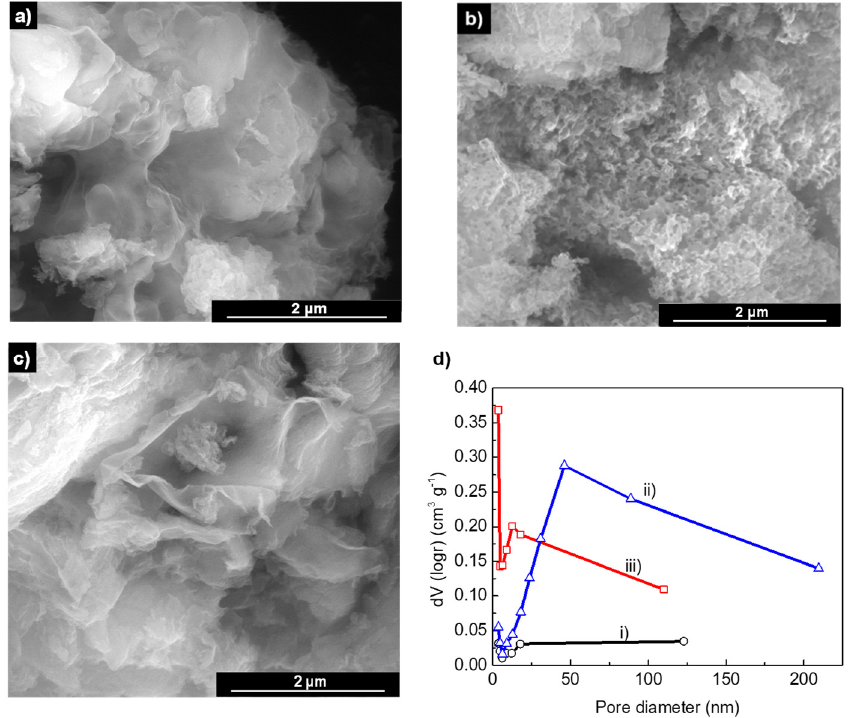
Figure 1. SEM micrographs of ( a ) GCN, ( b ) GCN-T-N, and ( c ) GCN-T. ( d ) Barrett–Joyner–Halenda pore volume distribution derived from the N 2 adsorption isotherms of (i) GCN, (ii) GCN-T-N, and (iii) GCN-T at − 196 °C. Table 1. The atomic ratio between carbon and nitrogen, specific surface area ( S BET ), XRD peak (002) width at half height (FWHM), and crystallite size ( d ) of the synthesized catalysts.